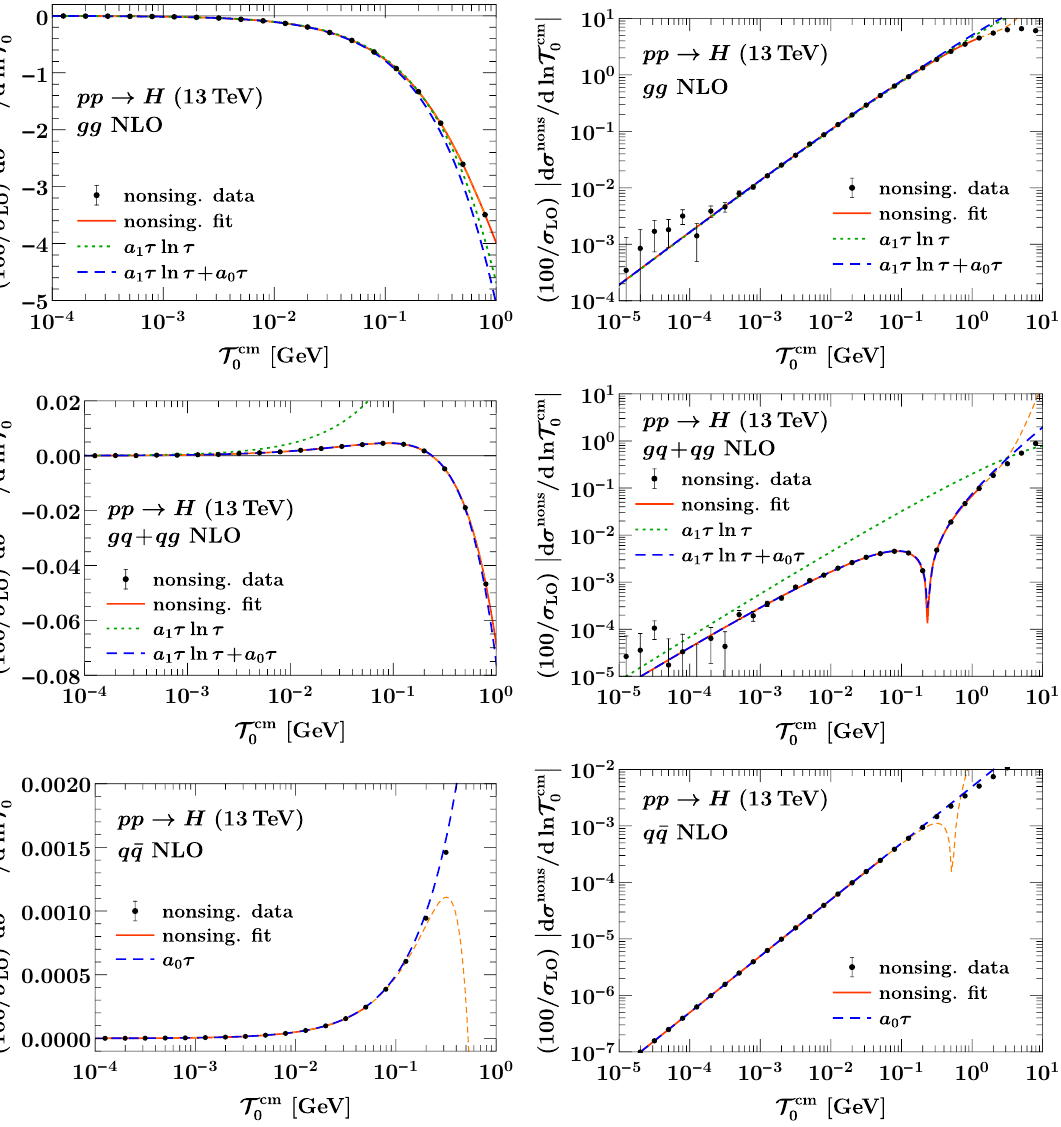
Figure 9 . Same as (cid:12)gure 7 for the hadronic T de(cid:12)nition.